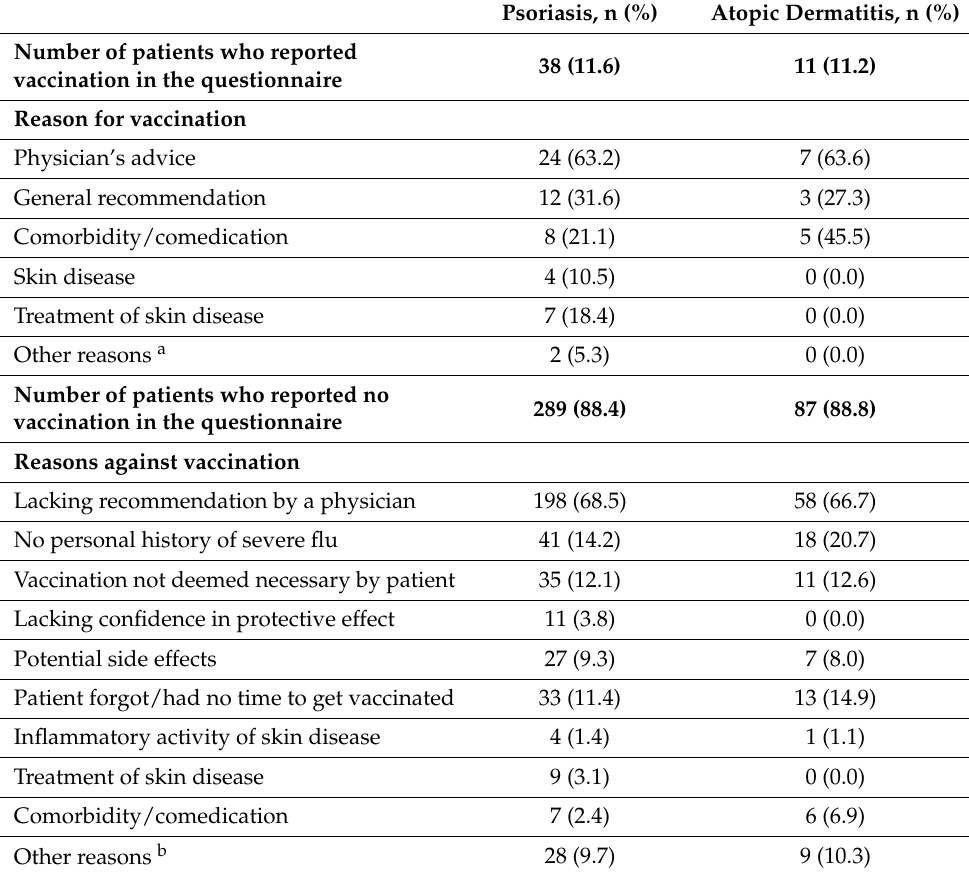
Table 2. Reasons for and against pneumococcal